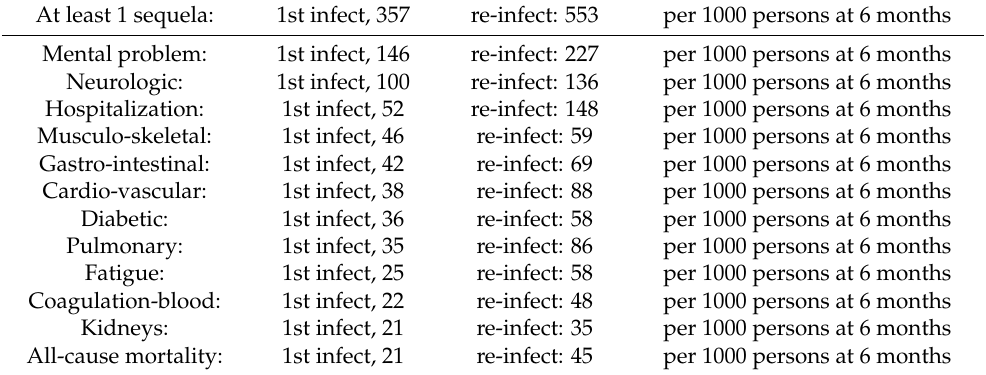
Table 1. The frequency of long COVID/PASC due to infection and